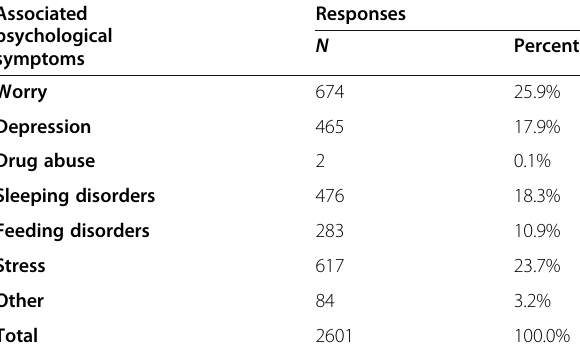
Table 2 Frequency distribution of other psychological symptoms among the study sample